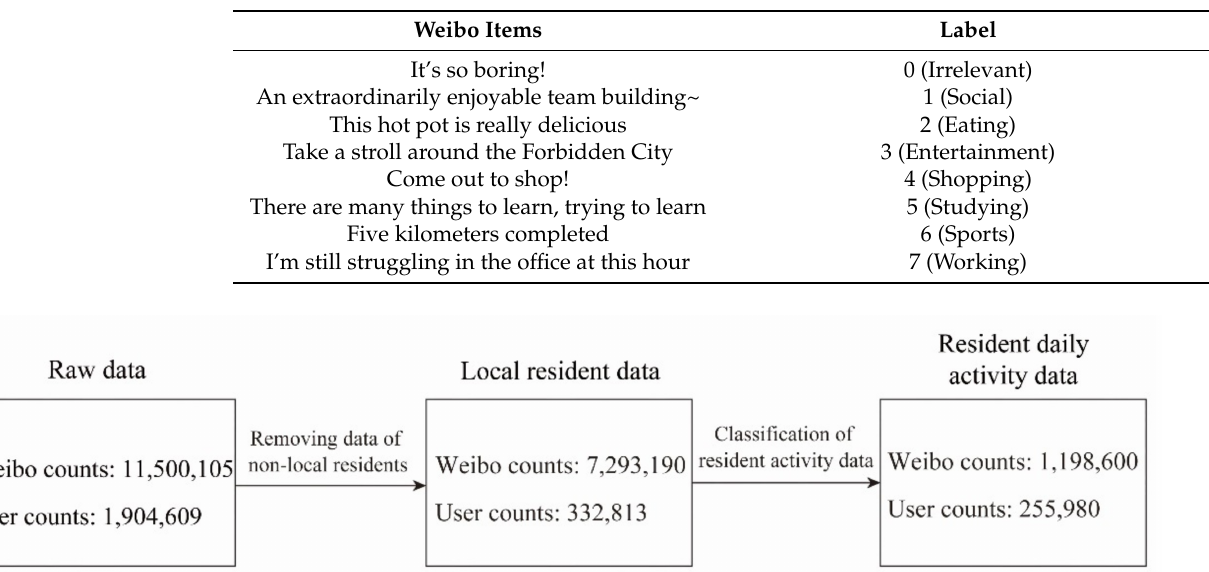
Table 2. Manual labeling example.